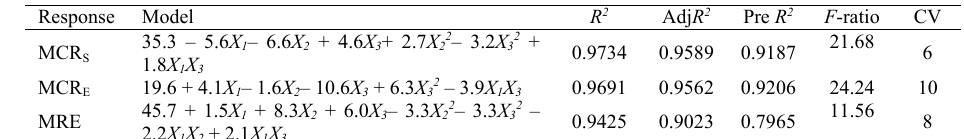
Table 5: Statistical analysis of the models in terms of the coded factors